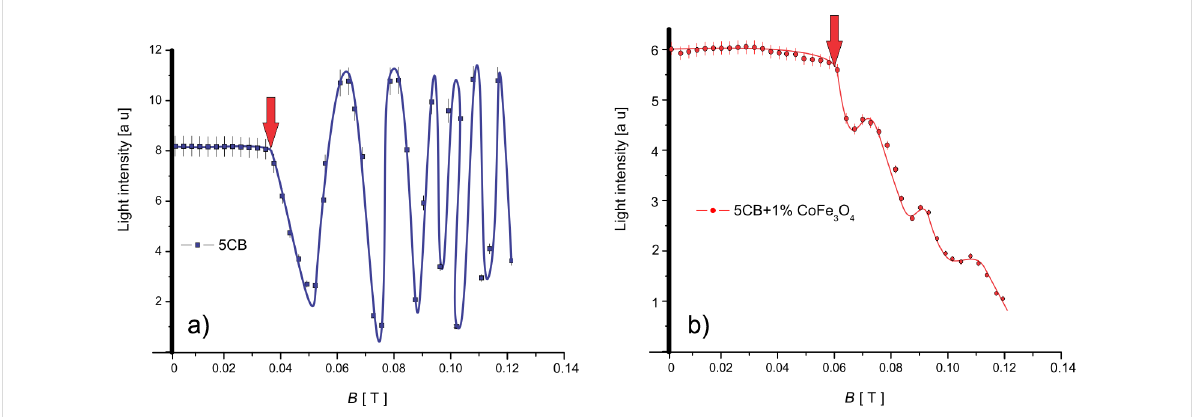
Figure 4: Magnetic Fréedericksz threshold for a) pure 5CB liquid crystals and b) the mixture of 5CB and CoFe 2 O 4 .